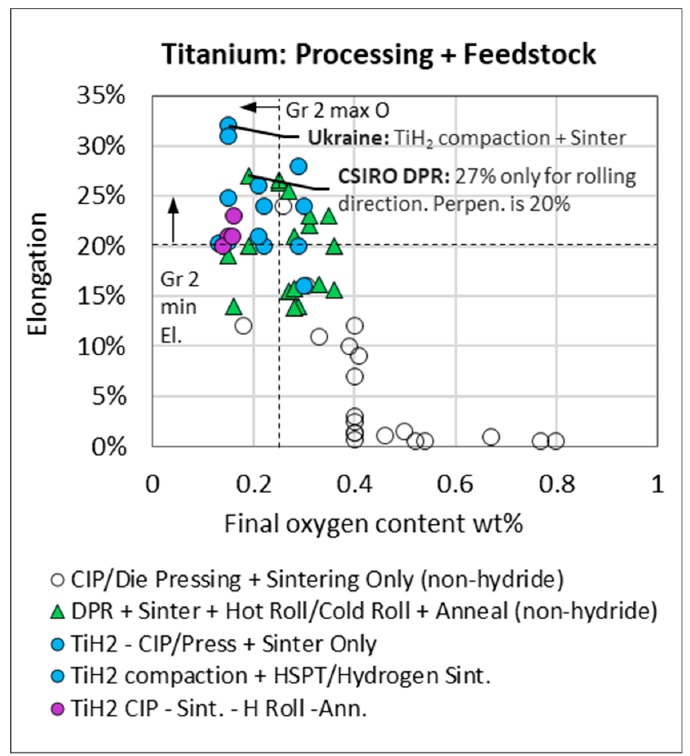
Figure 10. Elongation versus oxygen content for titanium compacts from hydride and non-hydride powder (12 sources).